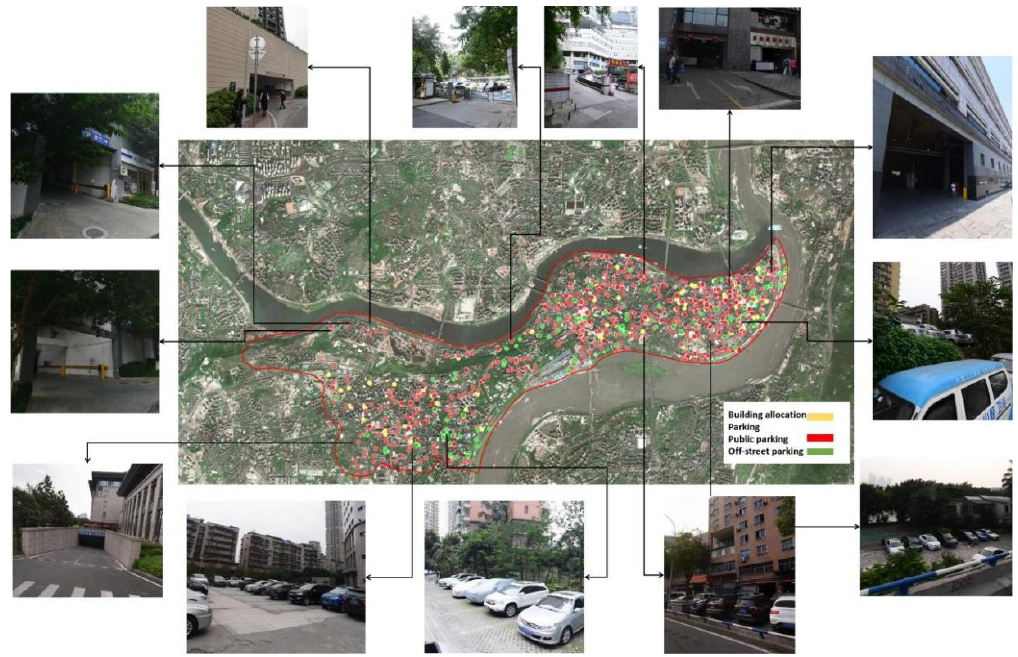
Figure 4. Selected locations of parking facilities in Yuzhong District.